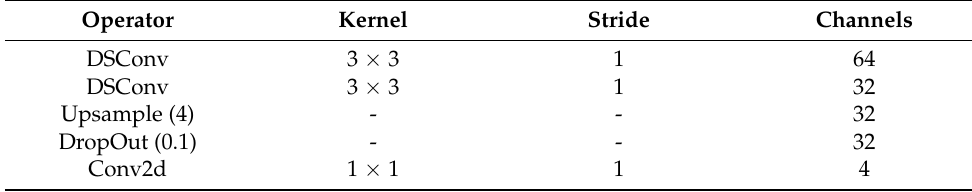
Table 6. Details of Classify